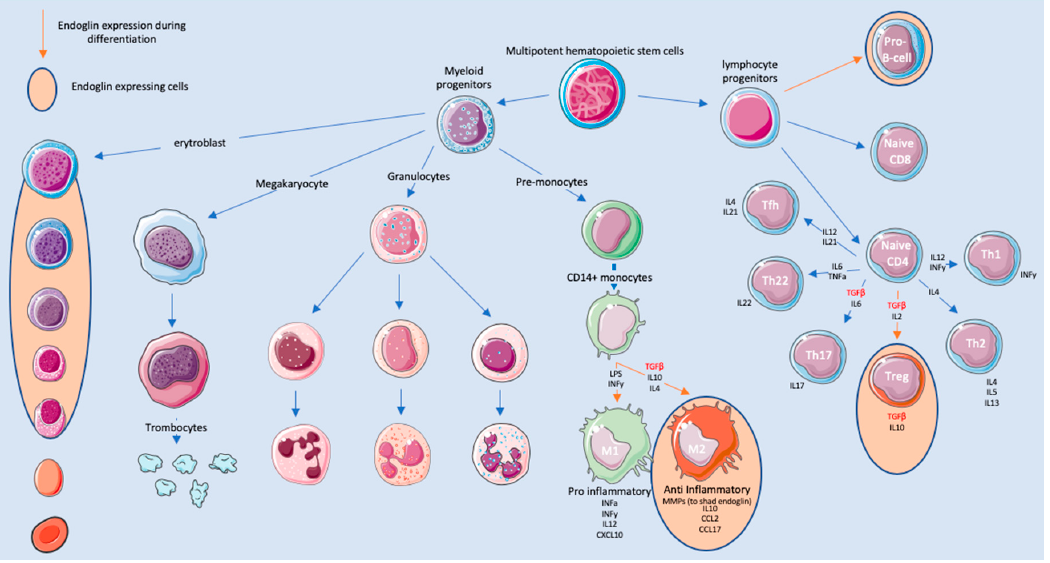
Figure 1. Endoglin during the development and differentiation of immune cells.